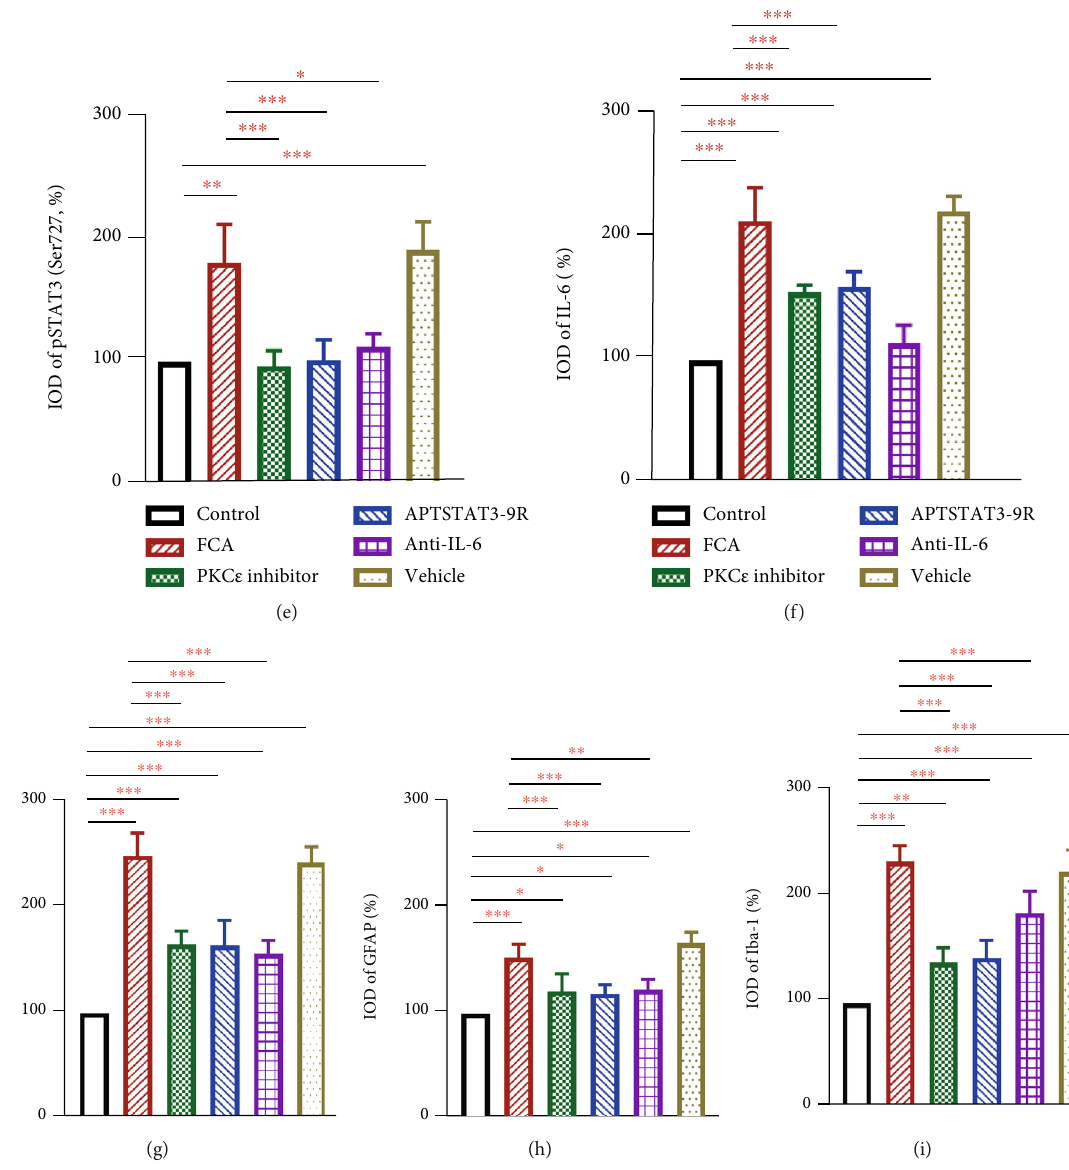
Figure 5: Expression of proteins related to activated neurocytes detected by Western blot analysis. (a – i) Protein expression of pSTAT3 (Ser727), IL-6, c-Fos, GFAP, and Iba-1 in the spinal cords of FCA-treated rats signi fi cant decreased ( P < 0 : 05 ) after intrathecal injections of PKC ε inhibitor peptide (100 μ g/50 μ L), APTSTAT3-9R (20 μ g/50 μ L), and anti-IL-6 antibody (100ng/50 μ L). Values were normalized against GAPDH and are expressed as ratios (%) of control values. Data are shown as means ± SD ( n = 4 – 5). ∗ P < 0 : 05 , ∗∗ P < 0 : 01 , ∗∗∗ P < 0 : 001 ; one-way ANOVA followed by Bonferroni